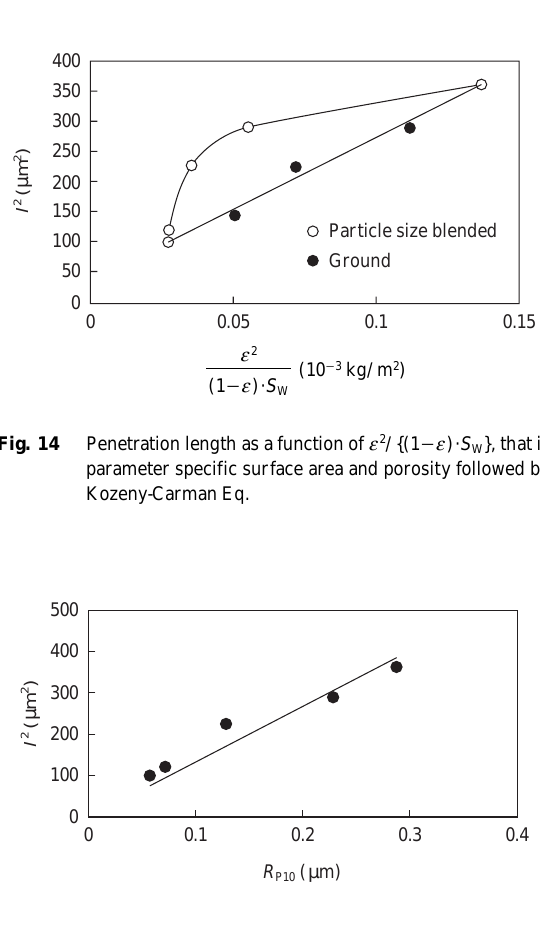
Penetration length as a function of pore size R P10 for par- ticle size blended powder